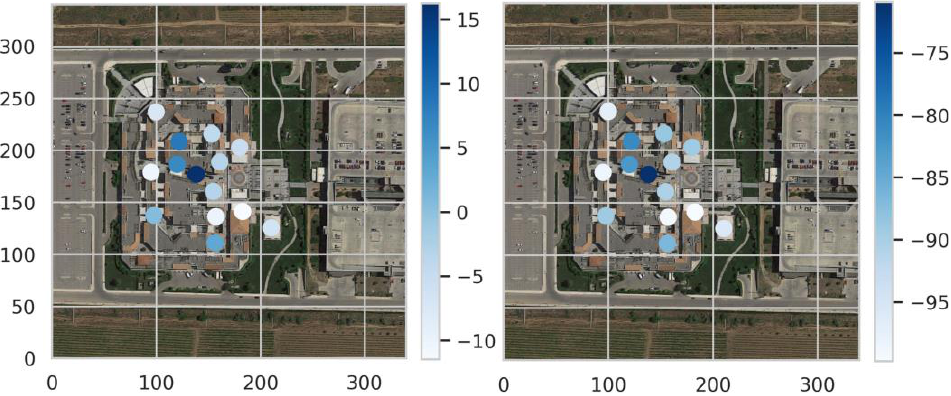
Figure 6. Hybrid network–spatial centroids colored by their SINR ( left ) and RSRP ( right )